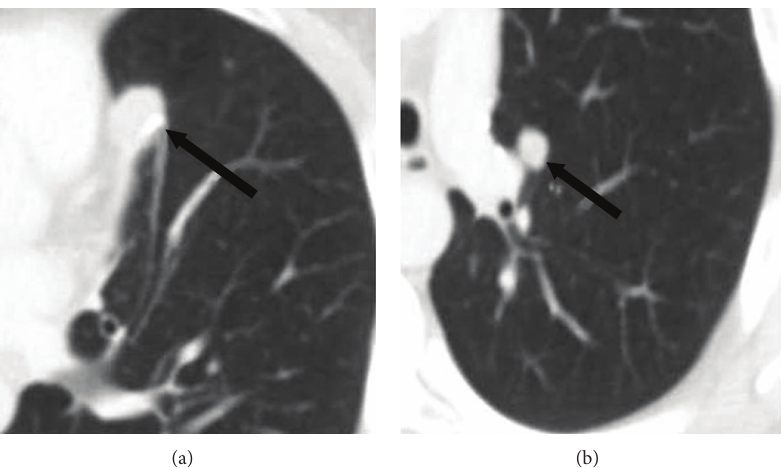
Figure 3: Radiologic features of recurrent malignant lung disease. Contrast enhanced axial CT image shows (a) a 1.9 × 1.4 cm nodular paramediastinal opacity and (b) a left 1.1 × 0.9 cm perihilar nodule. Histological examination demonstrated pure adenocarcinoma with the same EGFR exon 19 mutation that was present in the original